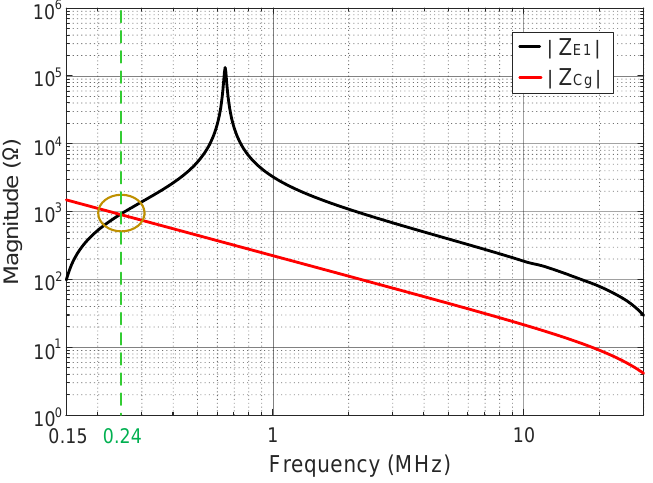
Figure 14. Impedance comparison between Z E1 (1.4 mH and 1 nF) and Z Cg .